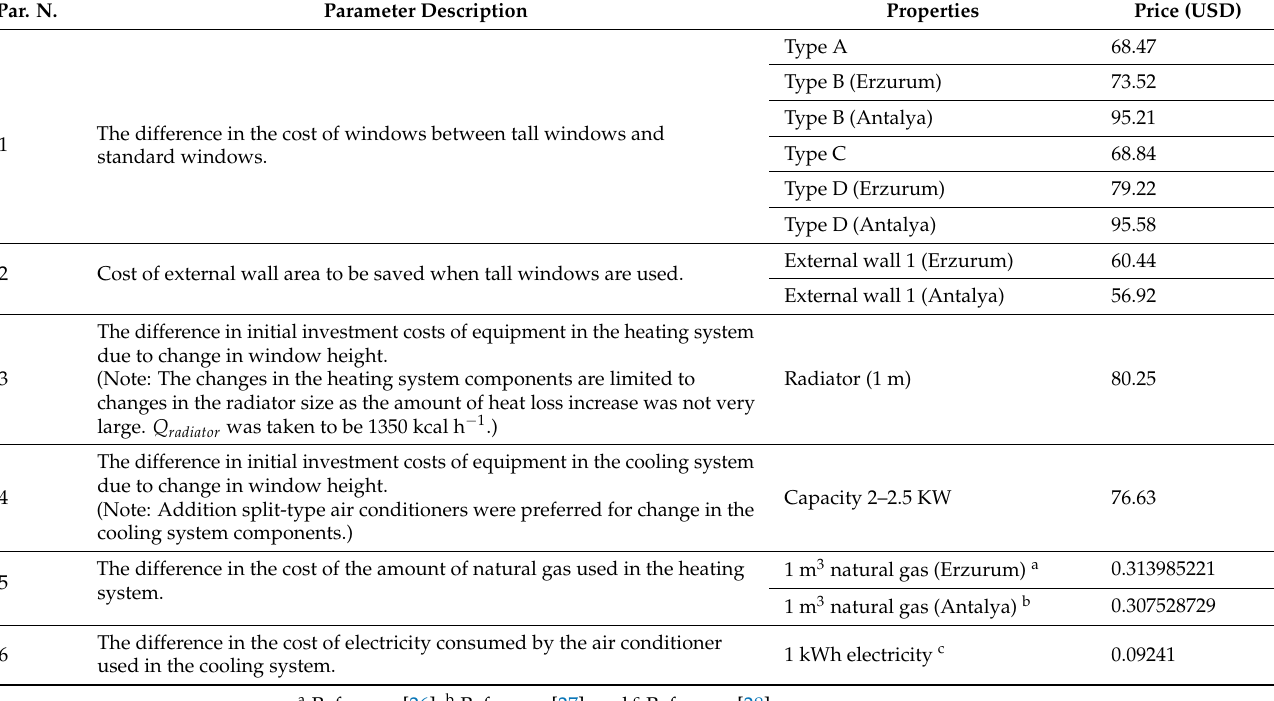
Table 11. Parameters and details used in cost